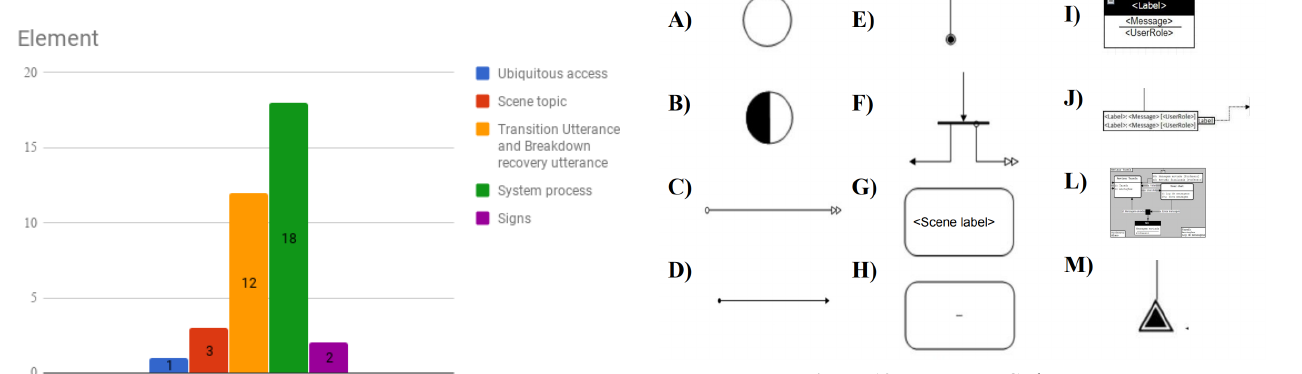
Figure 12. New MoLIC